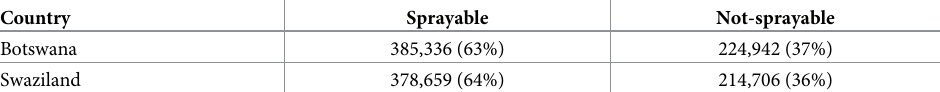
Table 5. Breakdown of predictions for all OSM structures in the country, including structures for which type is available.